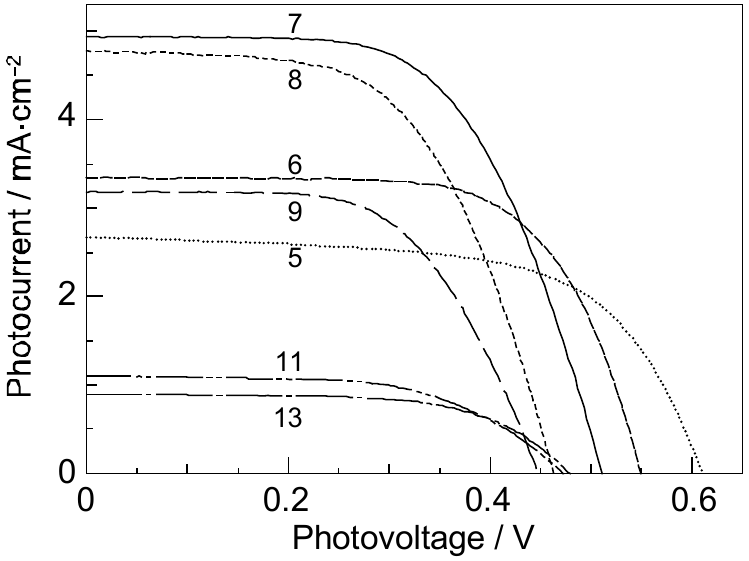
Figure 2. Conjugation-length ( n ) dependence of the I – V curves in solar cells using RA and CA sensitizers (reprinted from [3] with permission from